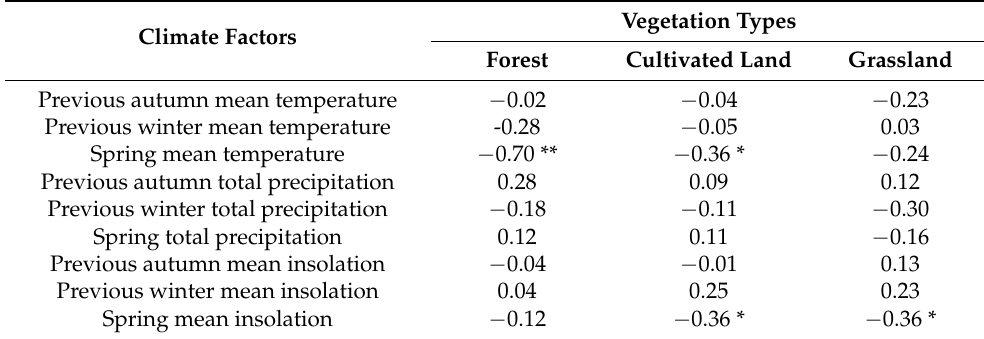
Table 9. Correlation coefficients between the EOS and climate factors in different vegetation types of northeast China in 1982–2014. Vegetation Types Climate Factors Forest Cultivated Land Grassland Spring mean temperature − 0.15 0.10 0.10 Summer mean temperature 0.21 − 0.15 0.15 Autumn mean temperature 0.16 Spring total precipitation